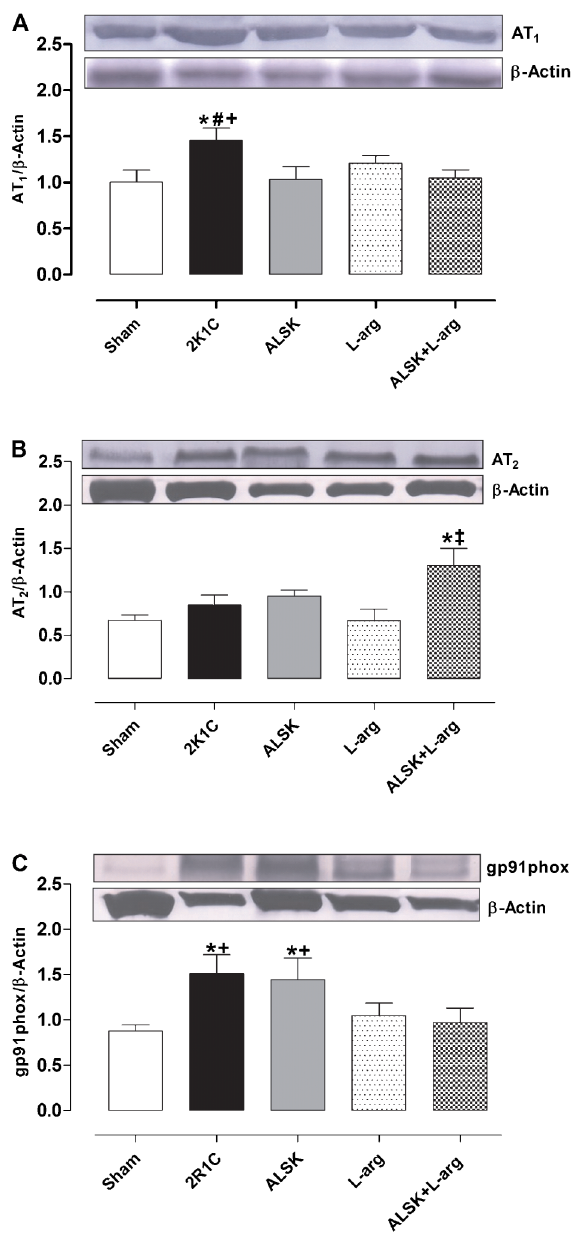
Figure 6. Densitometric analyses of angiotensin receptor-1 (AT 1 ) ( A ), AT 2 ( B ) and gp91phox ( C ) in aortas from Sham, 2K1C, aliskiren (ALSK), L-arginine (L-arg), and ALSK++L-arg treated rats. Data are reported as means±SE. *P , 0.05 vs Sham; # P , 0.05 vs ALSK; { P , 0.05 vs L-arg; + P , 0.05 vs ALSK++L-arg (one-way ANOVA, followed by Fisher’s post hoc